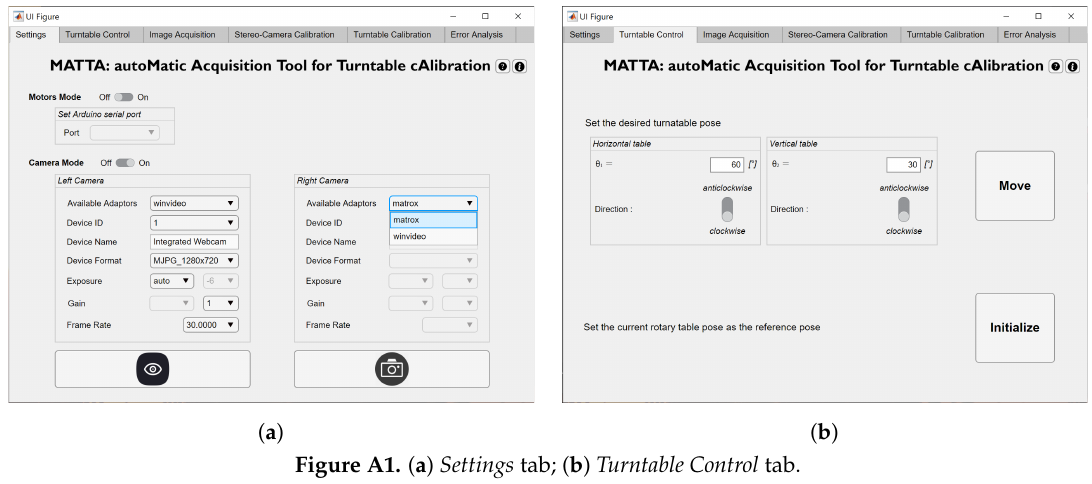
Figure A1. ( a ) Settings tab; ( b ) Turntable Control tab.